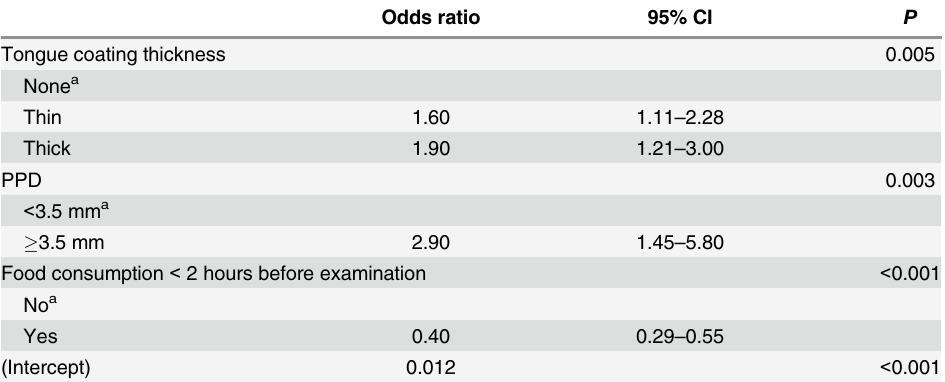
Table 5. Multiple logistic regression model for VSC values (0: < 110 ppb, 1: (cid:1) 110 ppb) # . Odds ratio 95% CI P